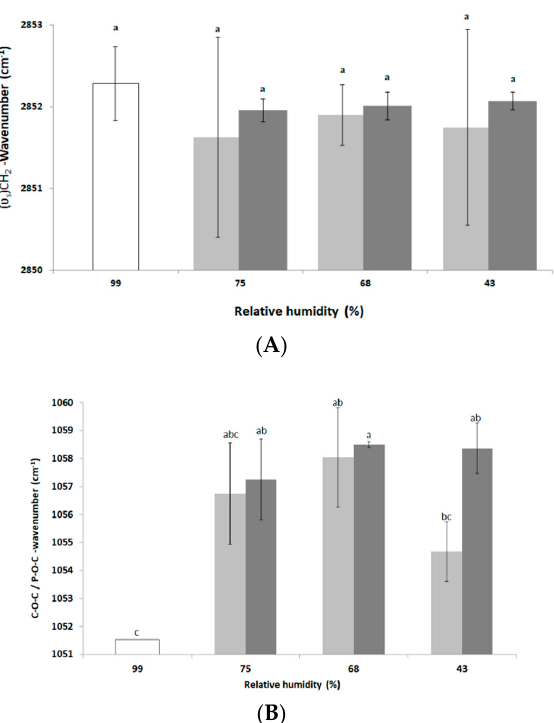
Figure 2. FTIR transmission spectroscopic analysis of L. monocytogenes EGDe components after dehydration. Cells were dehydrated at 25 °C and 75%, 68% or 43% RH for 3 h (light grey bars) or 16 h (dark grey bars) and then instantaneously rehydrated in PBS. Untreated cells (control, white bars) were maintained at 99% RH. FTIR spectroscopic analysis was performed on the second derivative spectra as explained in the Materials and Methods section. Changes in frequency of ( A ) symmetrical ( υ s )CH 2 and ( B ) C–O–C/P–O–C peaks. Error bars correspond to the standard deviation calculated from at least three independent experiments (except for control in ( B ) for which only one repetition could be run). Histogram bars followed by different letters indicate significant differences ( p < 0.05) as determined by the Tukey post hoc test.